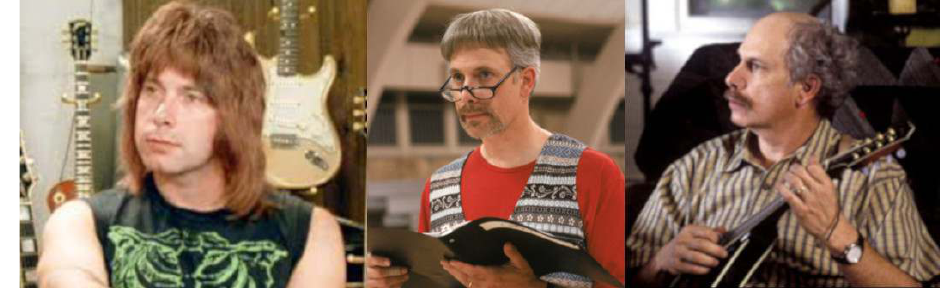
Sources, left to right: https://happybday.to/Christopher-Guest?page=2; https://www.tvguide.com/ celebrities/christopher-guest/144775/; http://exclaim.ca/ fi